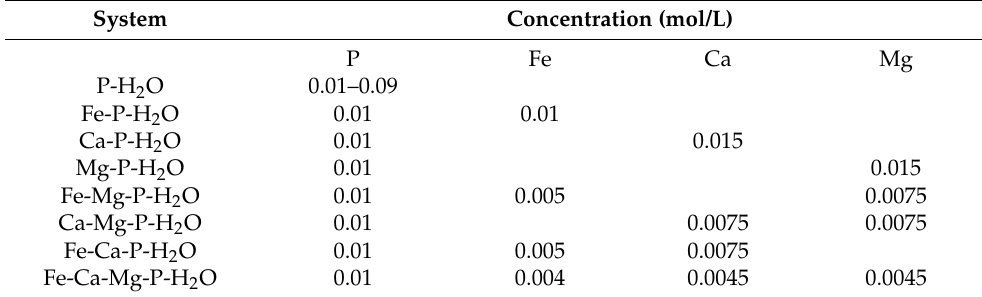
Table 1. The concentration for simulating process.